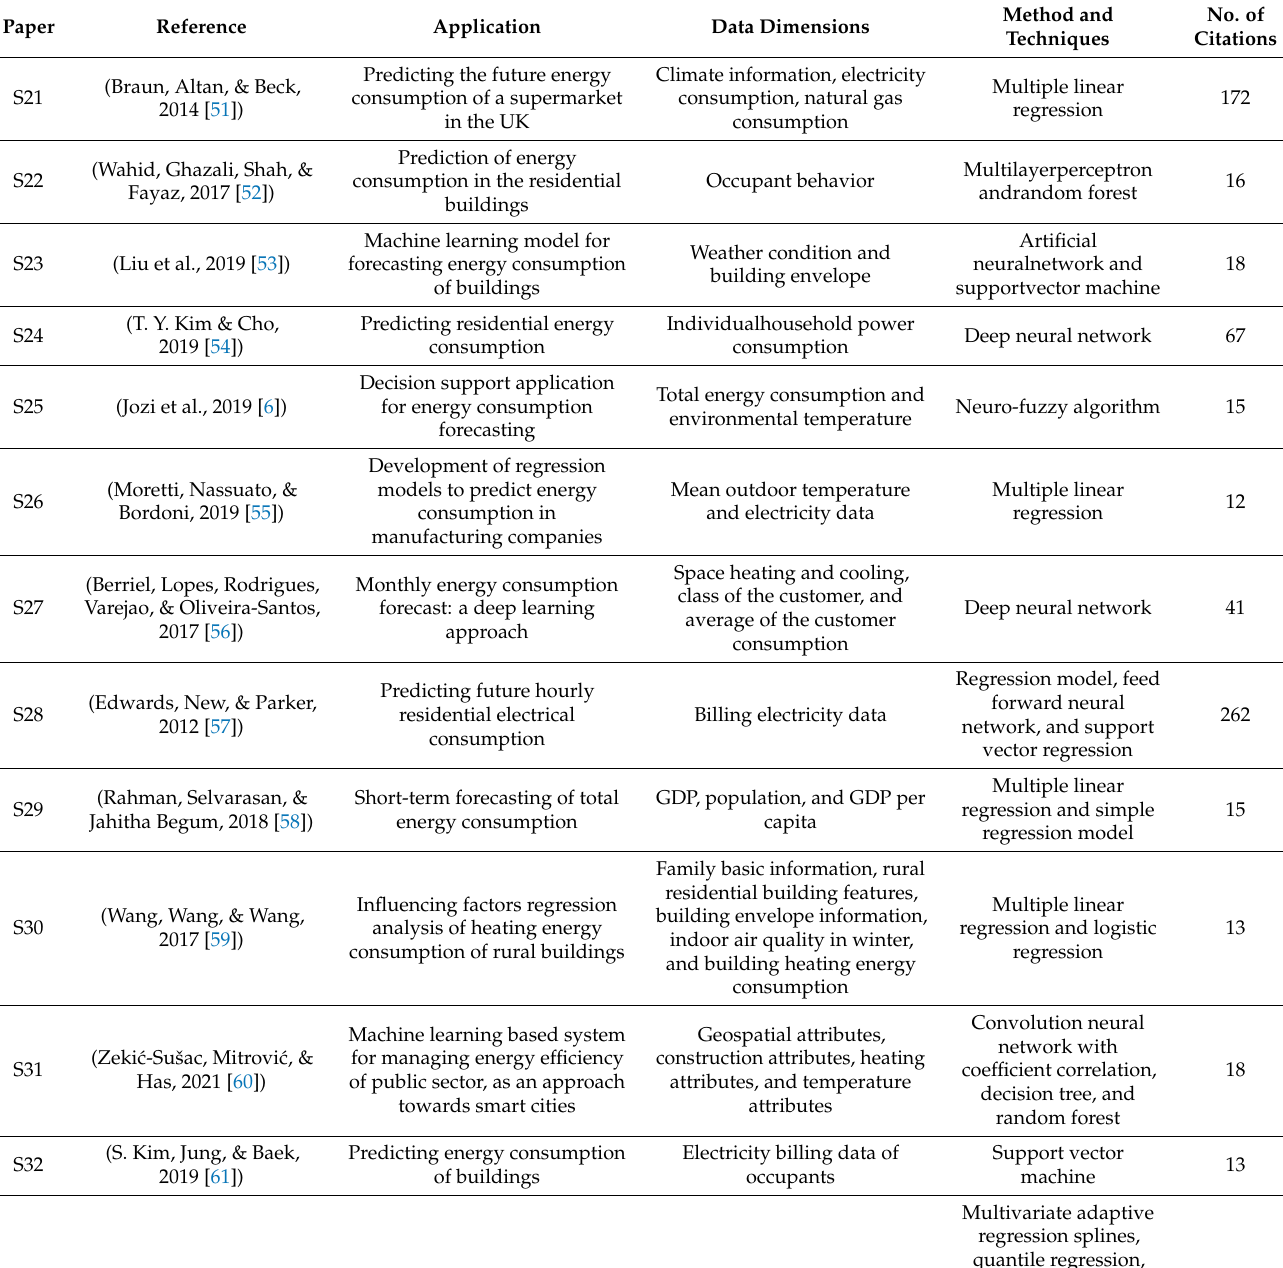
Table 3. Summary of papers in the category of prediction of energy consumption of